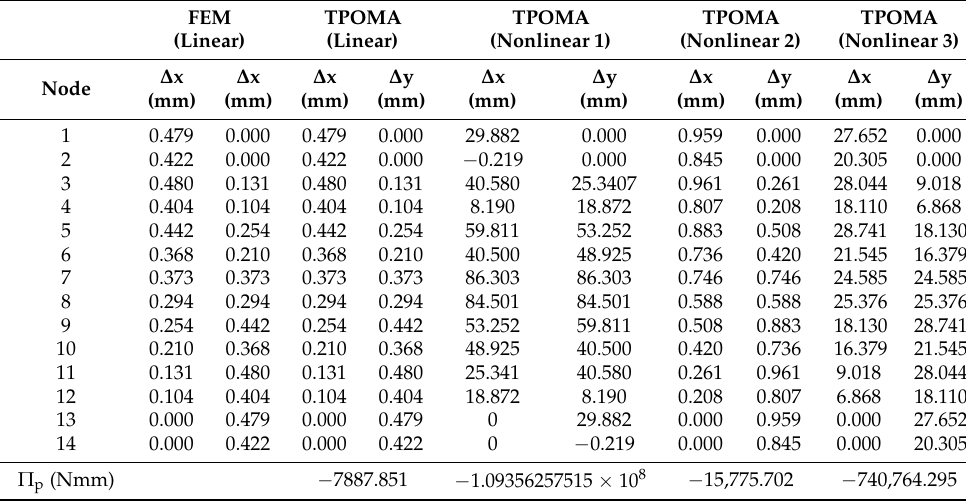
Table 6. Optimum results for the system with 12 members-14 nodes (AHS).